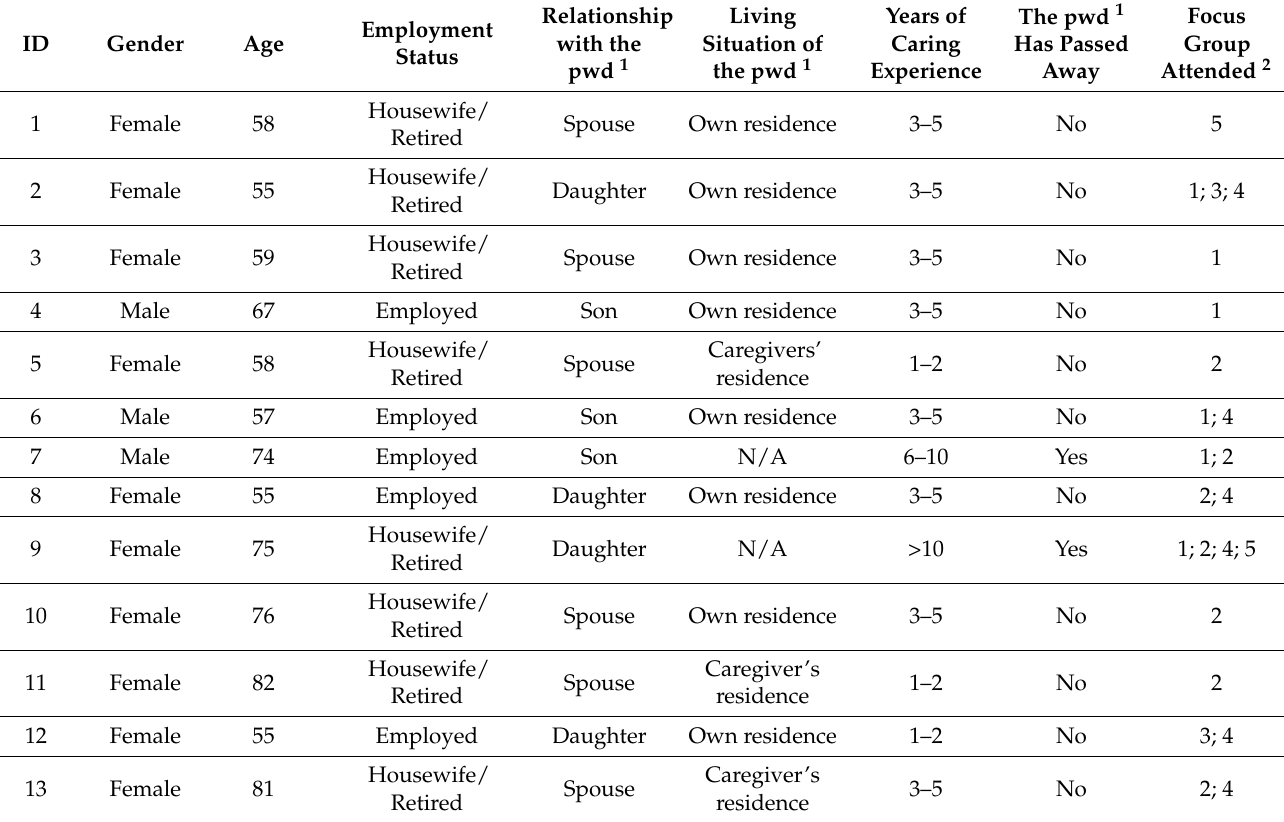
Table 1. Sociodemographic characteristic of